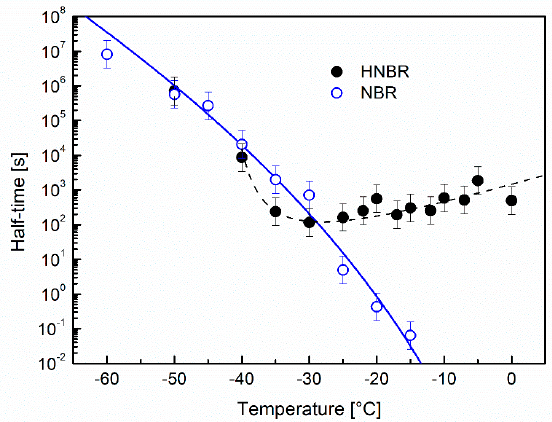
Figure 9. Half time of the annealing process as a function of the annealing temperature for NBR and HNBR. The curves just serve as an indication.